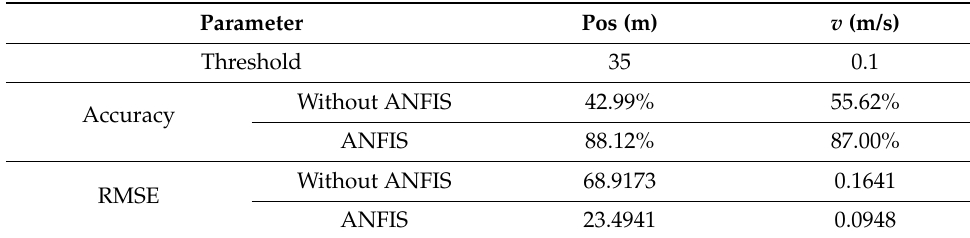
Table 9. Accuracy and RMSE comparison results.